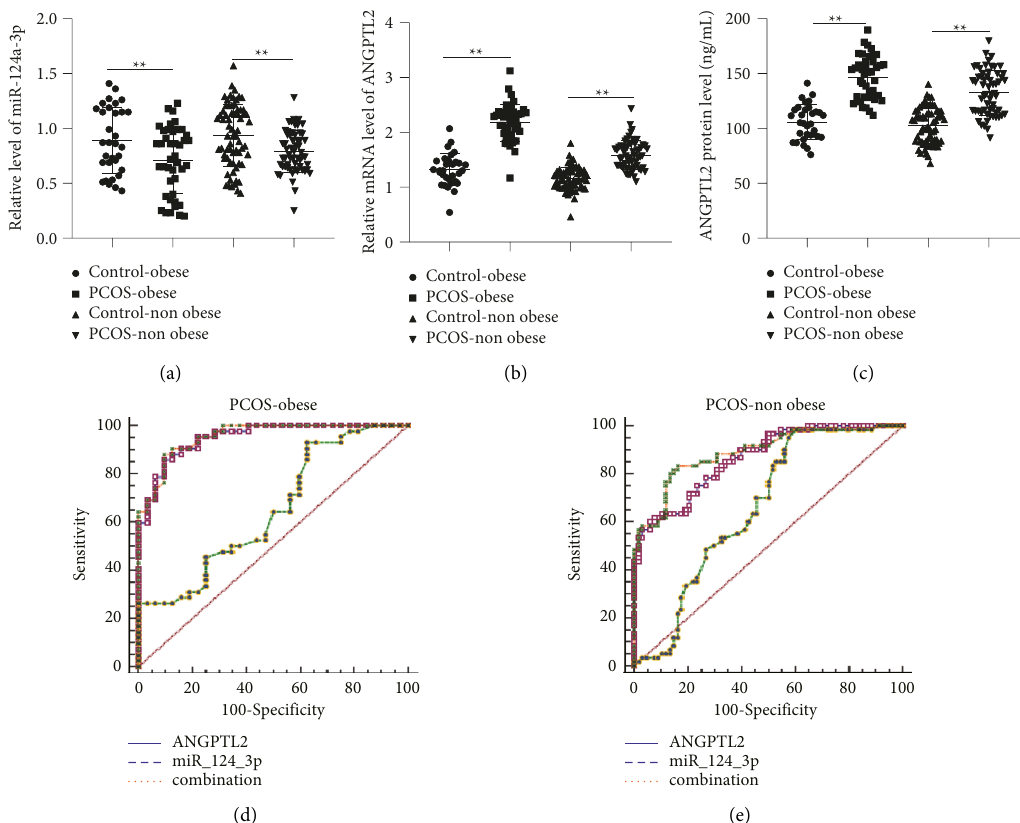
Figure 1: Expression patterns of miR-124-3p and ANGPTL2 in the serum of obese and nonobese PCOS patients and their clinical diagnostic efficacy. (a, b) Expression patterns of miR-124-3p and ANGPTL2 in serum of obese and nonobese PCOS patients ( N � 102) and healthy subjects (control, N � 100) were detected by RT-qPCR. (c) Expression patterns of ANGPTL2 in the serum of obese/nonobese PCOS patients ( N � 42/60) and healthy obese/nonobese subjects ( N � 32/68) were detected by ELISA. (d, e) ROC curve was adopted to analyze serum miR-124-3p or/and ANGPTL2 in the diagnosis of obese and nonobese PCOS. Data among multiple groups were analyzed by one-way ANOVA, followed by Tukey’s multiple comparisons test. ∗∗ P < 0 .